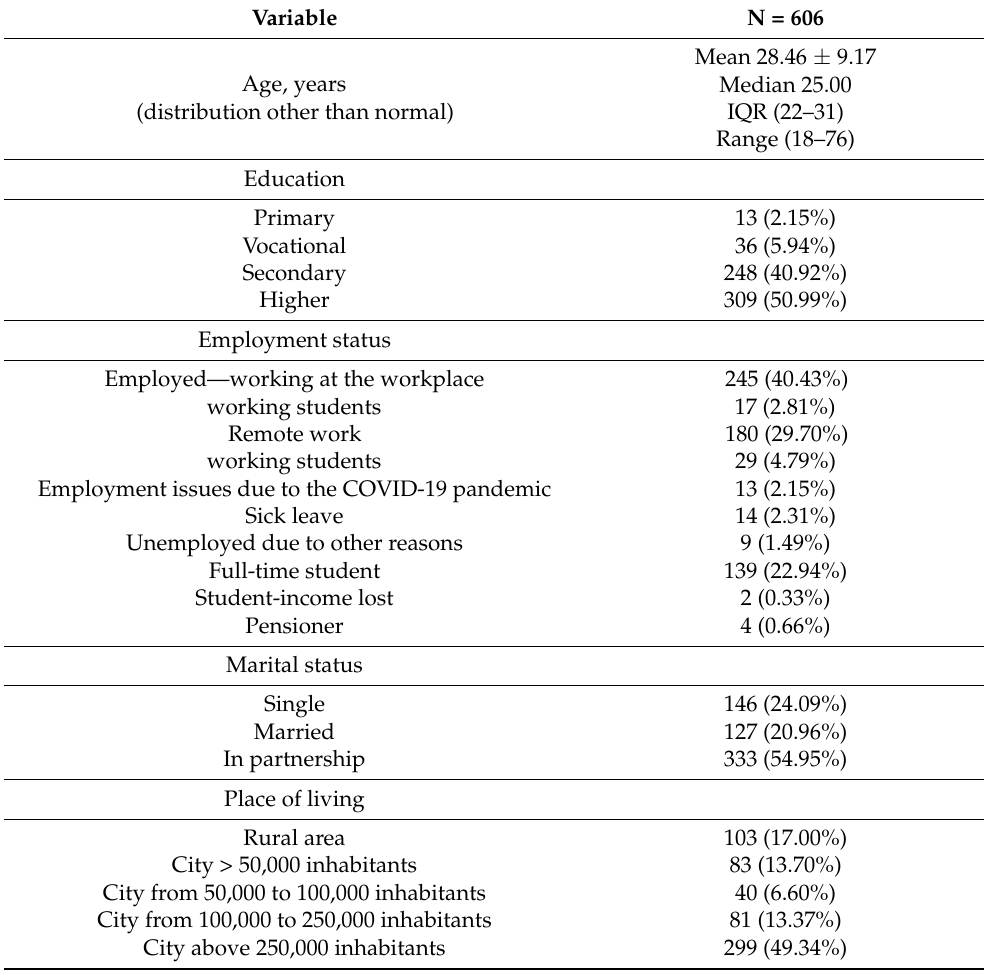
Table 1. Sociodemographic characteristics of the group. Variable N = 606 Age,